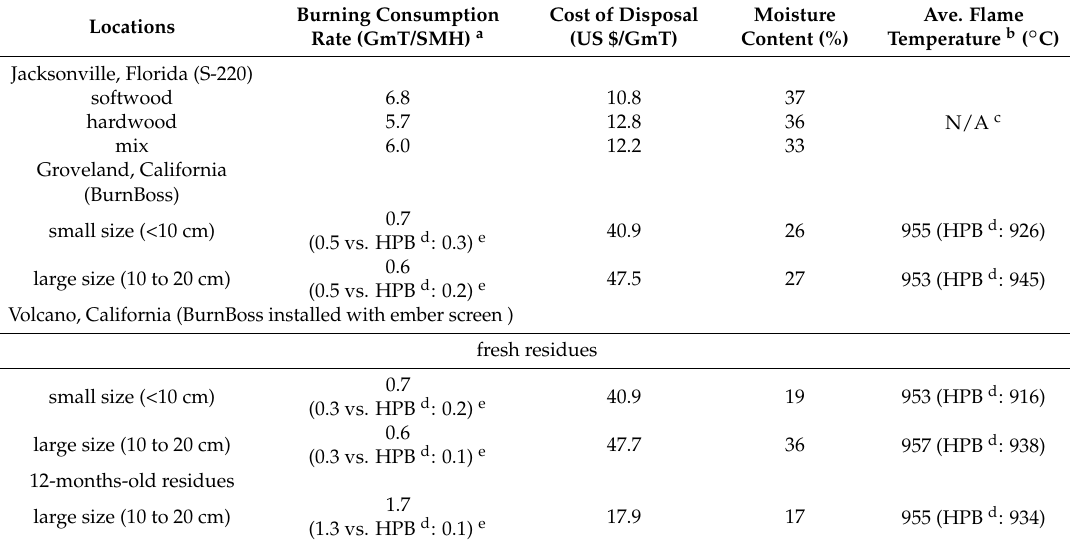
Table 3. Burning consumption rate, cost, maximum flame temperature of disposing forest residues using Air Curtain Burners (ACB) and hand-pile